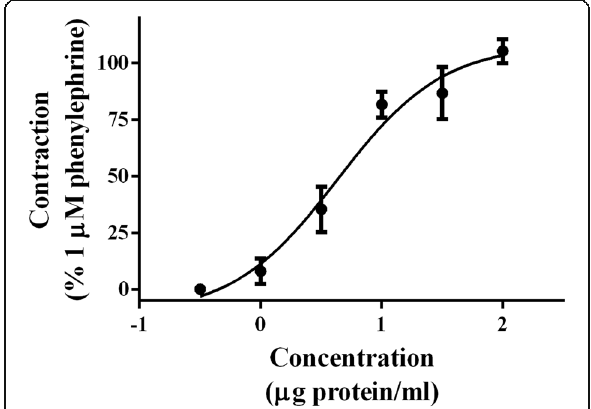
Fig. 2 Concentration-response curve showing the vasoconstrictor effect of P. caribaeorum venom on rat isolated aorta. Values are expressed as mean ± S.E.M. ( n = 3). Concentration represents protein content in the extracts